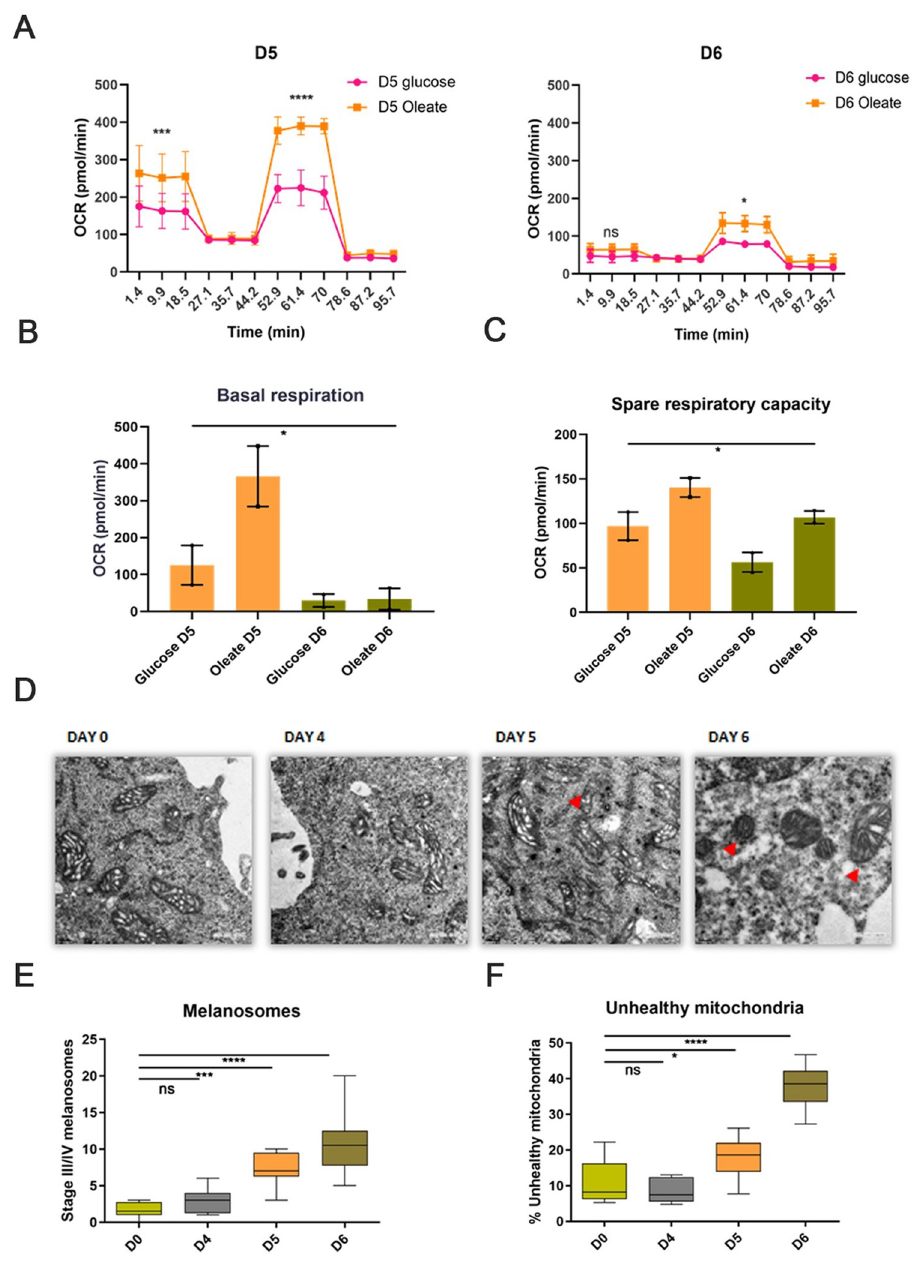
Fig 4. Fatty acids are preferred carbon source for mitochondrial respiration during pigmentation. (A) Comparative analysis of oxygen consumption rate in glucose or fatty acid supplemented media on D5 and D6 using Seahorse Mito Stress Test assay. Represented plot depicts Mean ± SEM for 2 independent biological replicates with 3 technical replicates in each set. Two-way ANOVA is applied. Sidak’s multiple comparison test is performed for pairwise analysis. p -Value. ���� p -value < 0.001, ��� p -value < 0.005, �� p -value < 0.01, � p -value < 0.05. ns is not significant. ( B) Quantitative analysis of basal respiration in glucose or fatty acid supplemented media on D5 and D6. Mean ± SEM is plotted for 2 biological replicates with 3 technical replicates for each set. One-way ANOVA is applied F (3,4) = 9.337, p -value = 0.028. ( C) Quantitative analysis of spare respiratory capacity in glucose or fatty acid supplemented media on D5 and D6. Mean ± SEM is plotted for 2 biological replicates with 3 technical replicates for each set. One-way ANOVA is applied F (3,4) = 8.915, p -value = 0.0303. ( D) Representative TEM-based analysis showing mitochondrial cristae morphology change during pigmentation from D3 to D6 (Number of cells, n = 8). Images were taken at 3500 × magnification. Scale is 0.2 μ m (Bottom left). ( E) Box plot depicting quantitative analysis of stage III/IV melanosomes on different days (Number of cells, n = 8). Whiskers represent min and max range with